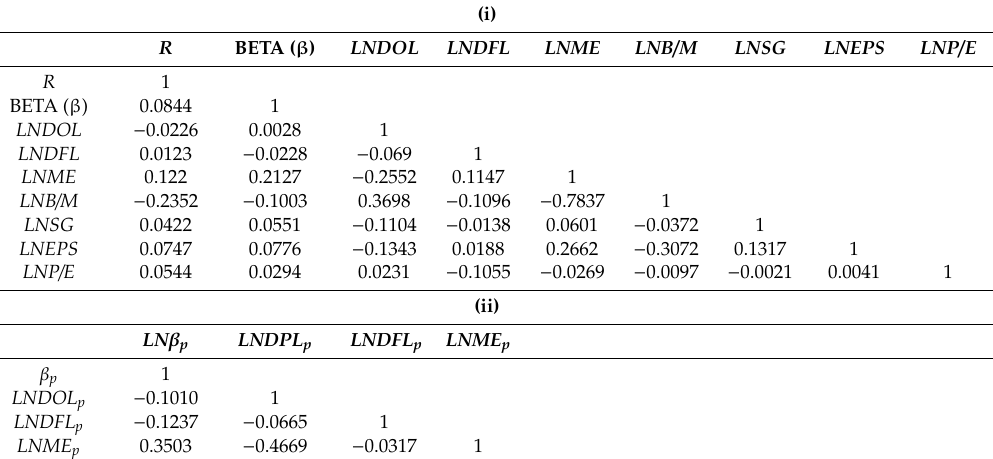
Table 2. (i): Correlation between firm specific variables. (ii): Correlation between portfolio variables.